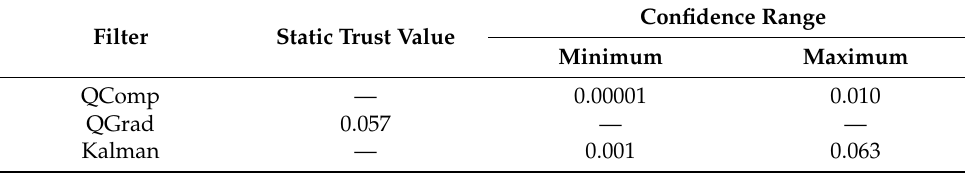
Figure 1. ( a ) IRB 2600 industrial robot, with all joints and axes of rotation labelled ( b ) IMUs positioned in a custom-made holder attached to the robot mounting interface, with the default coordinate system of IMUs superimposed on the image. Table 1. Accelerometer trust